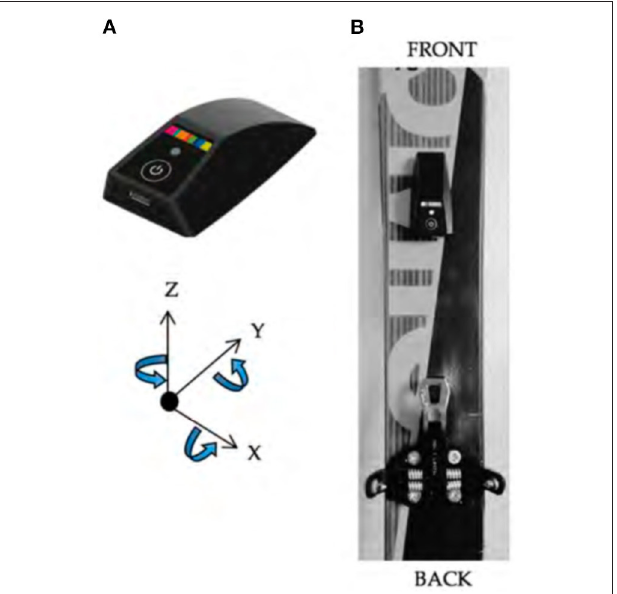
FIGURE 2 | (A) Ski-mounted multisensor IMU used by the three athletes (containing a 3D accelerometer, a 3D gyroscope, a barometer, a thermometer, a CPU, and solid-state memory). (B) Position on the ski in front of the front-binding ( Gellaerts et al., 2018).